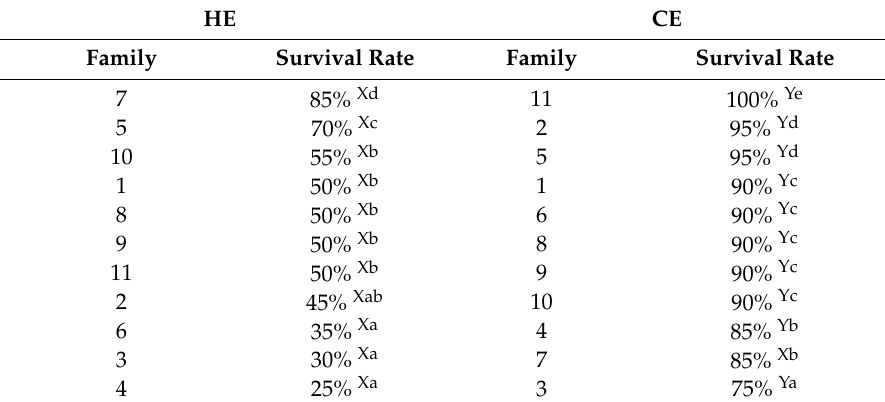
Table 2. Ranking of survival rate of families (from high to low survival) after high temperature in two simulated environments. Differences between families and between temperature environments were tested by Chi-square